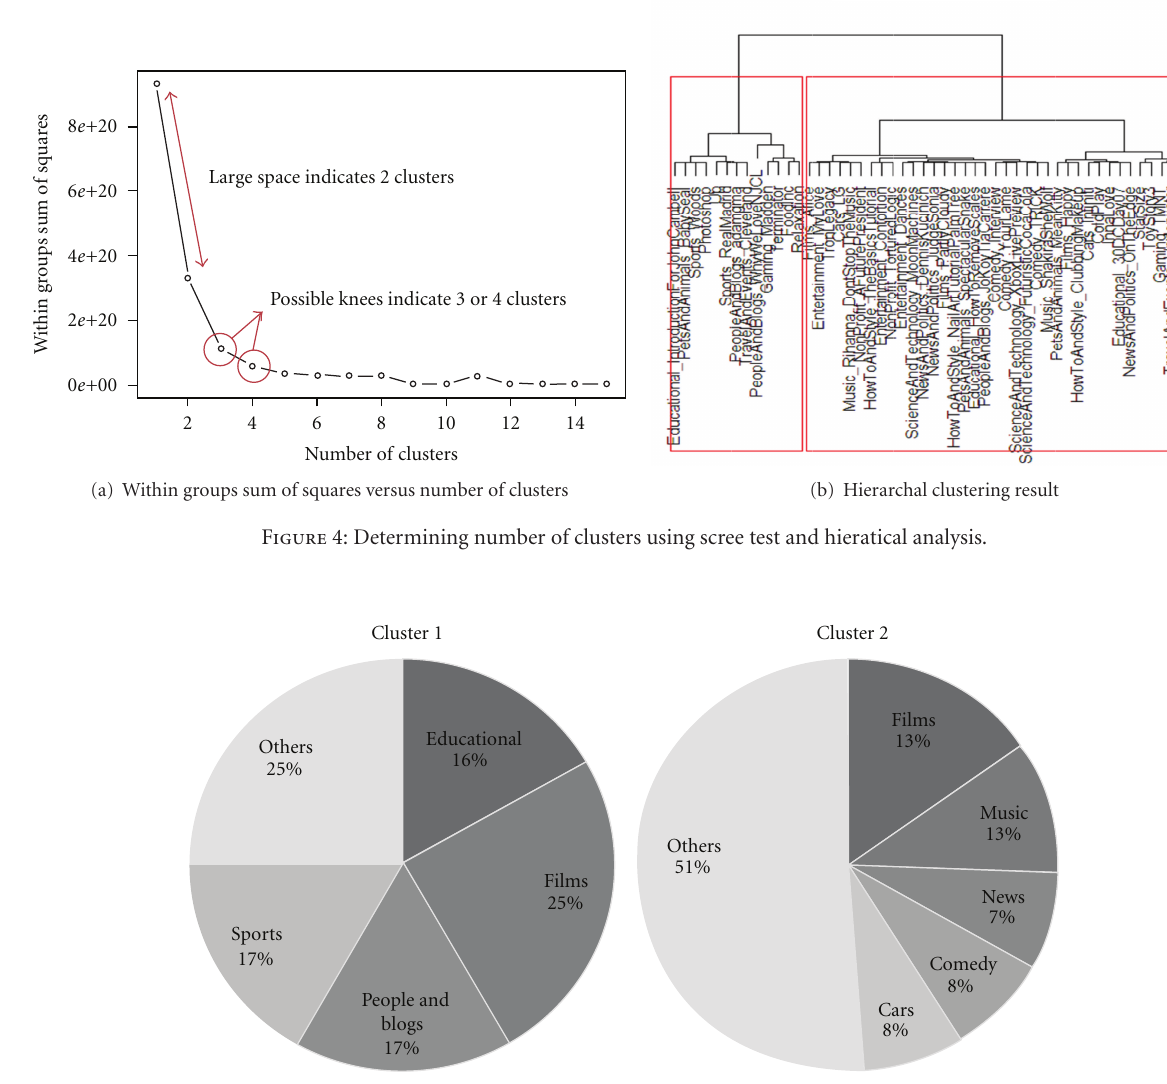
Figure 5: Distribution of movie groups over the two